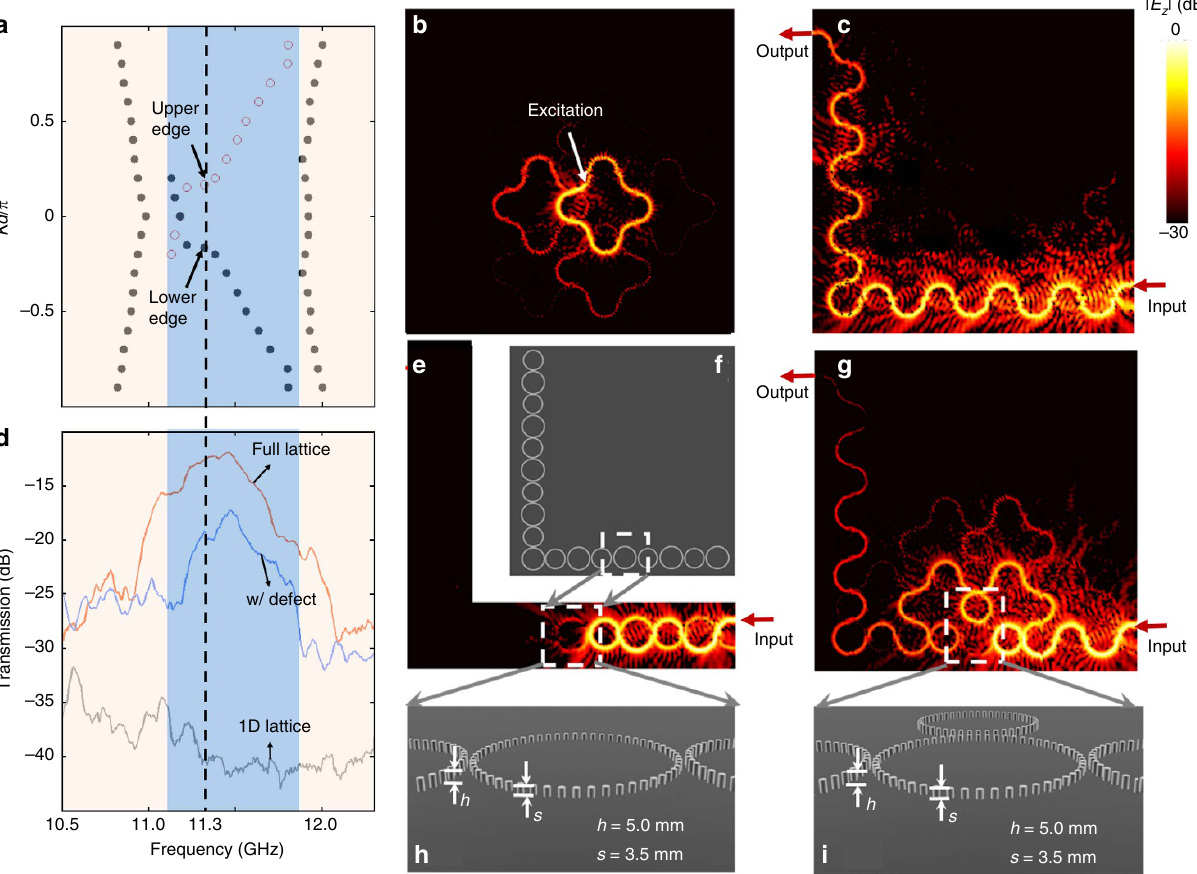
Figure 4 | Demonstration of topological edge state. ( a ) Simulated band diagram of the narrow-band designer surface plasmon structure. ( b ) Observed field pattern when the excitation is inside the bulk at frequency 11.3GHz. ( c ) Observed edge state at frequency 11.3GHz. ( d ) Transmission spectra of configurations in c , e and g . ( e ) The defect (shown in h ) causes strong reflection for a 1D lattice ( f ). ( g ) The edge state circumvents a defect lattice (shown in i ) consisting of metallic rods with height s ¼ 3.5mm. All other rods have the height h ¼